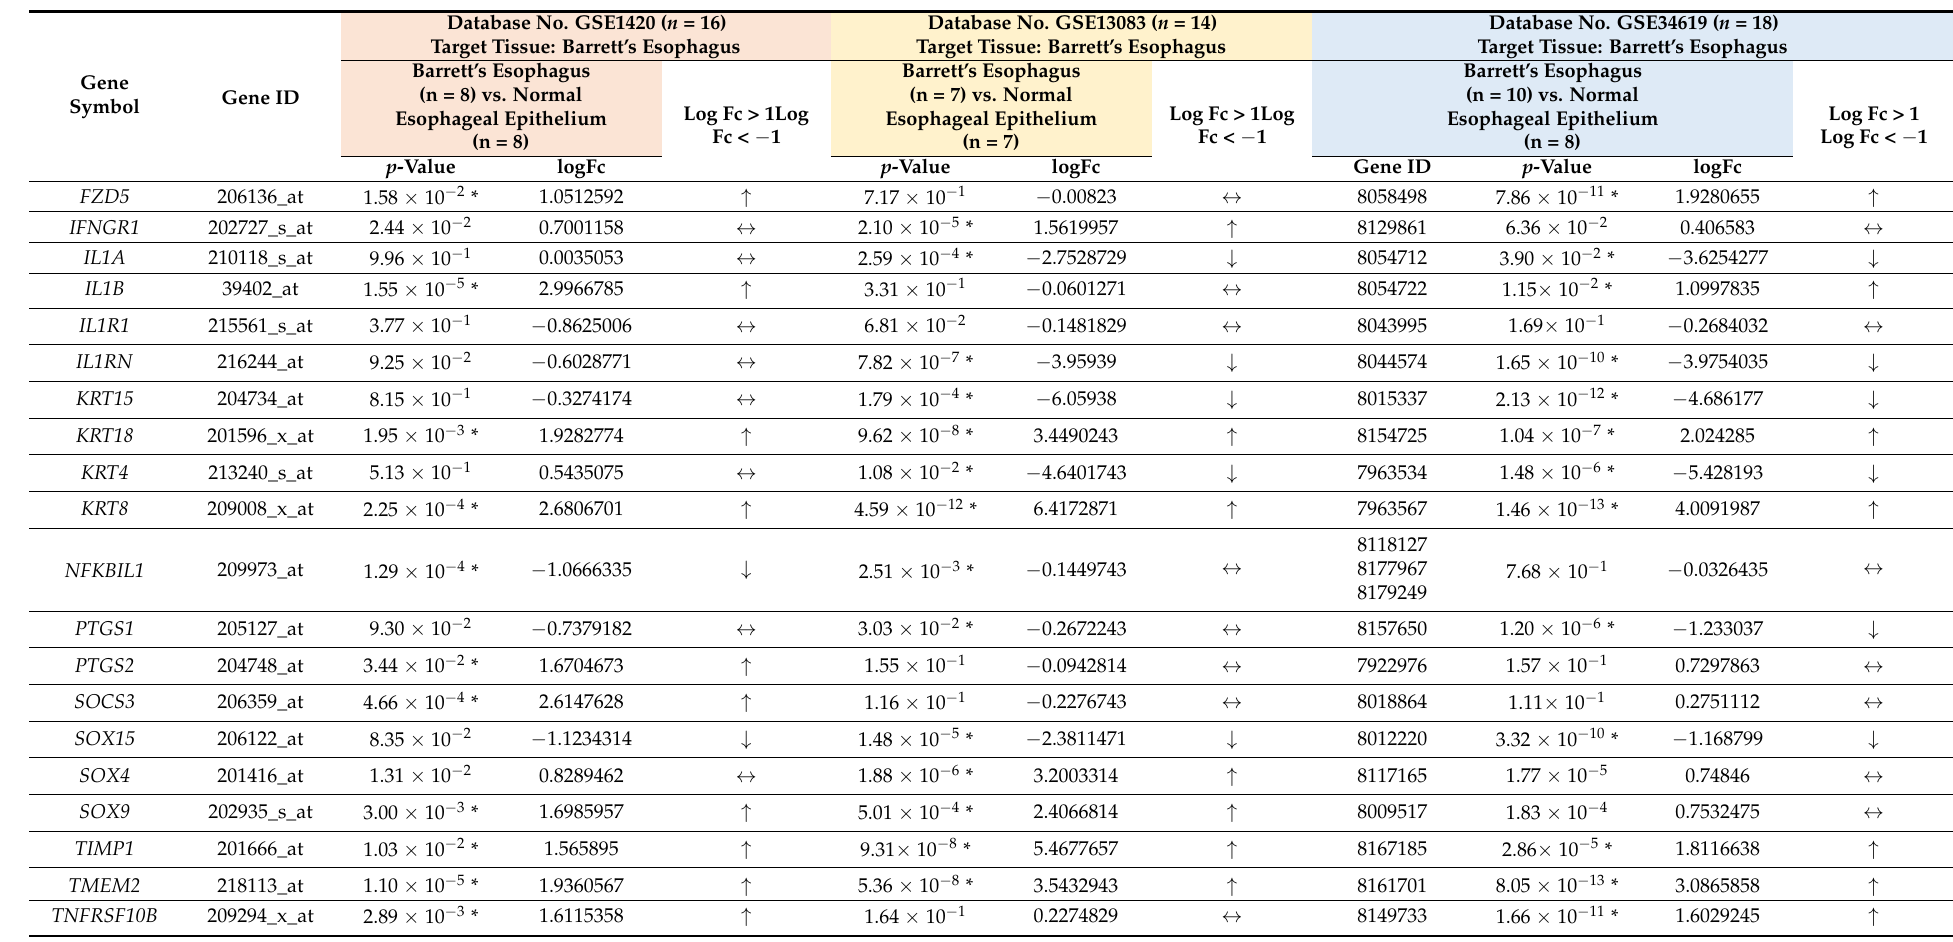
Table 2. Alterations in the expression of selected genes as seen in biopsies derived from patients with Barrett’s esophagus (BE), compared to normal squamous epithelium (without BE). The analysis was performed in three different databases (GSE1420, GSE34619 and GSE13083). Asterisk (*) indicates statistically significant difference with p < 0.05 in parallel with biologically significant logFC values lower than − 1 or higher than 1. The arrows indicate changes in mRNA expression in BE: an arrow up ( ↑ ) indicates upregulation of mRNA expression, an arrow down ( ↓ ) indicates downregulation of mRNA expression, and a double-sided arrow ( ↔ ) indicates lack of changes in mRNA